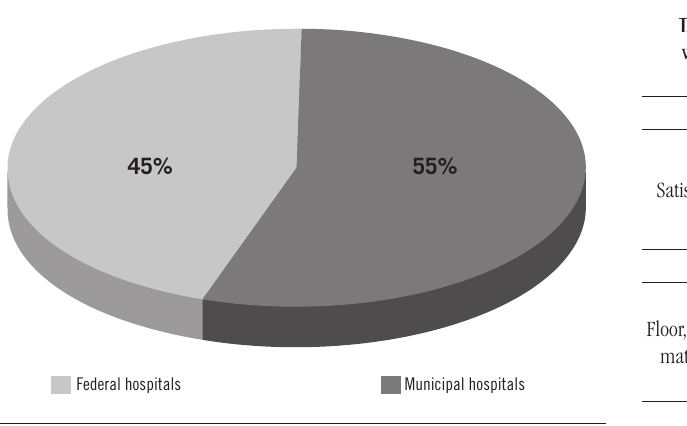
taBLE 2 − Satisfactory sanitation conditions, floor, wall and ceiling in